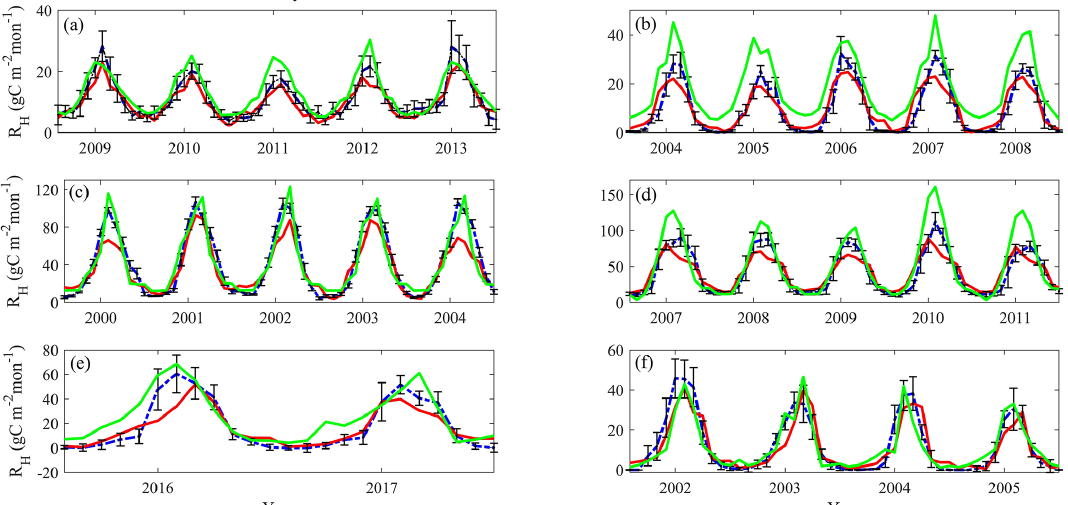
Figure 5. Comparison between observed and simulated R H (gCm − 2 per month) at (a) US-EML (alpine tundra), (b) CA-SJ2 (boreal forest), (c) US-Ho2 (temperate coniferous forest), (d) US-UMB (temperate deciduous forest), (e) US-Ro4 (grassland), and (f) RU-Che (wet tundra). Note: scales are